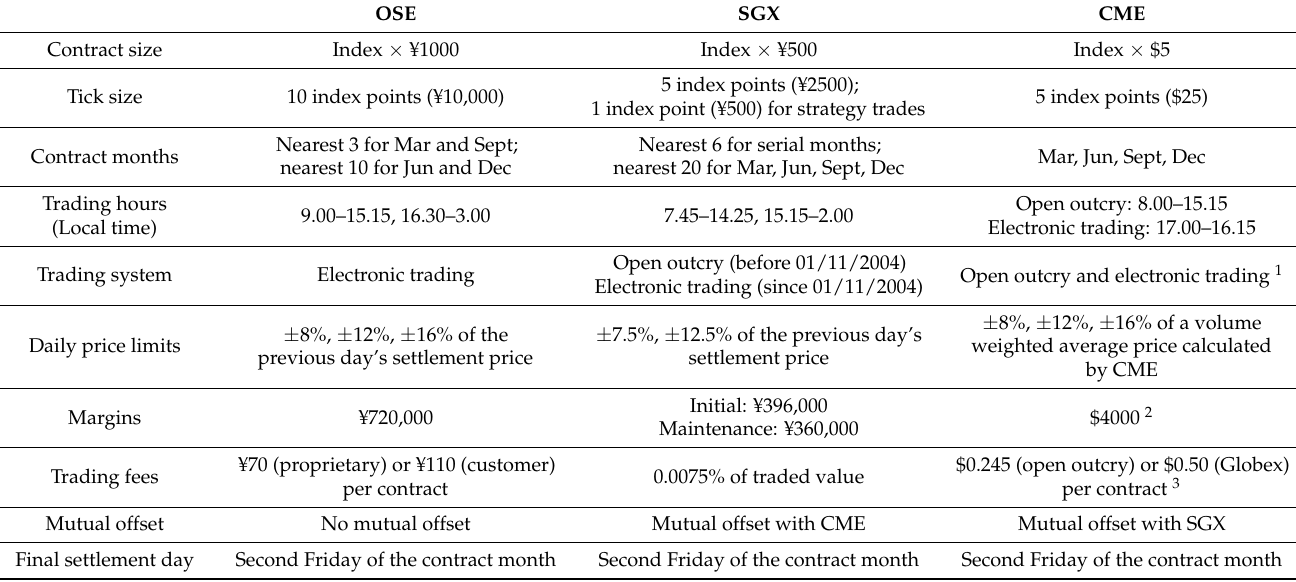
Table 1. The Nikkei futures